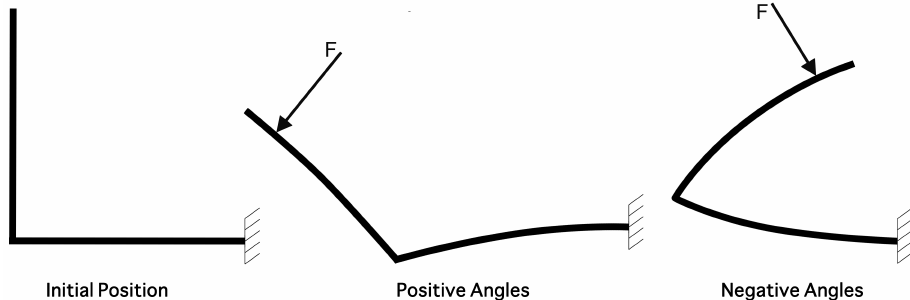
Figure 7. Deflection angle orientations.